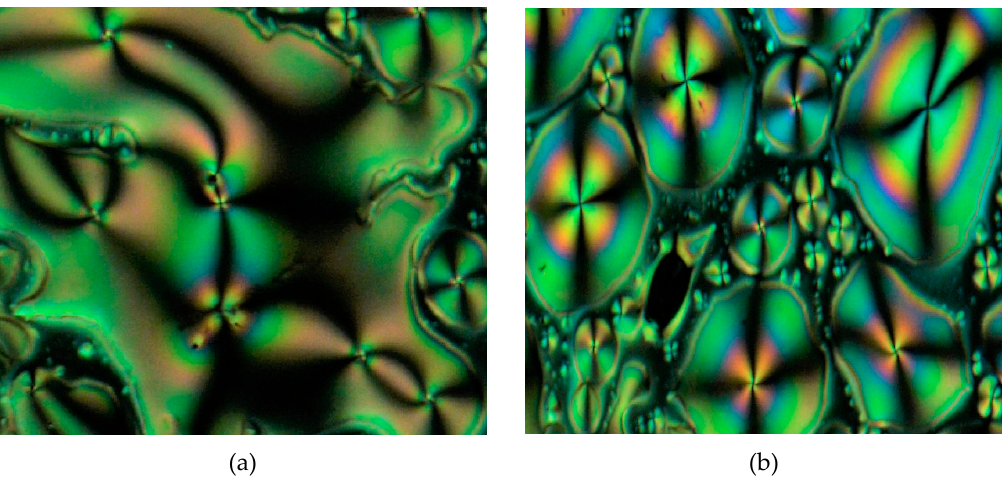
Figure 11. The optical photomicrographs of compound 4f in the cooling cycle: ( a ) droplets at 211.38 °C, and ( b ) thread-like schlieren texture of nematic phase at 215.88 °C (Magnification of 20 × 0.25).